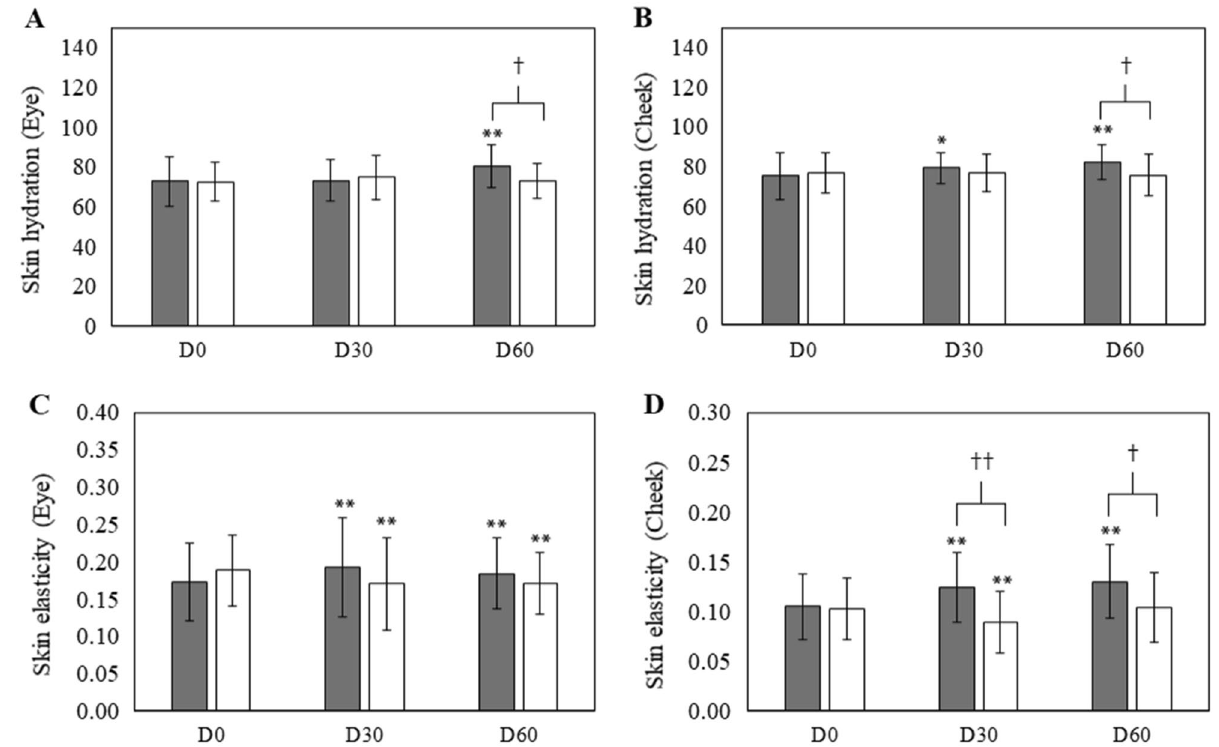
Figure 4. Skin hydration and skin elasticity measured at two skin sites, ( A ) the corner of eye; ( B ) under cheek bone and skin elasticity measured at two skin sites, ( C ) the corner of eye; ( D ) under cheek bone at baseline (D0), after 30 d (D30) and 60 d (D60) of application in the test ( ) and placebo groups